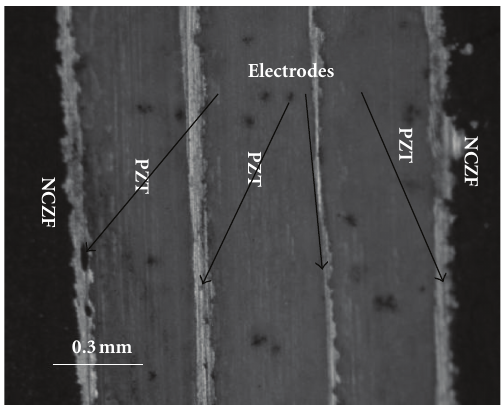
Figure 20: Cross sectional optical image of NCZF-Stack [0.9 PZT- 0.1 PZN]-NCZF trilayer.